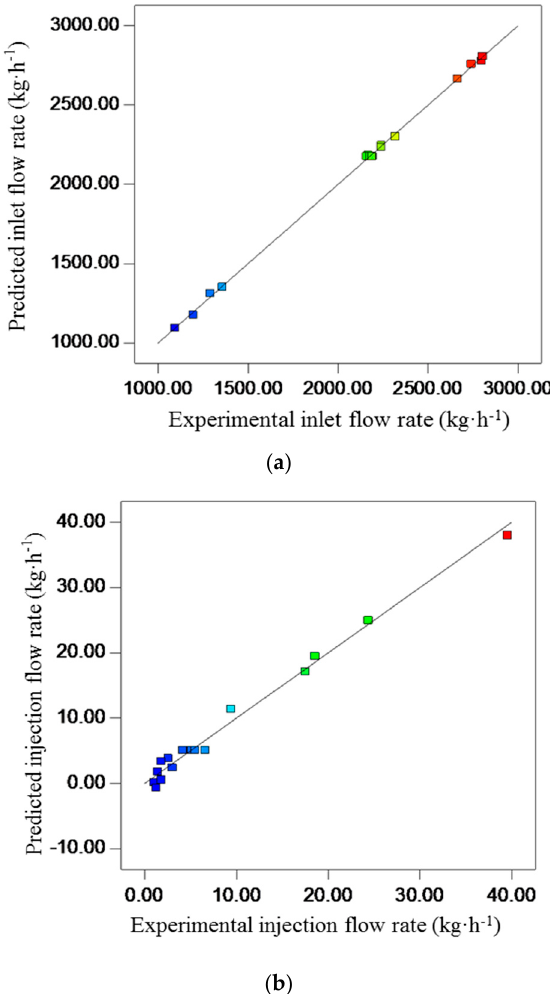
Figure 8. Plot of actual values versus predicted values: ( a ) Q il ; ( b ) Q ij .